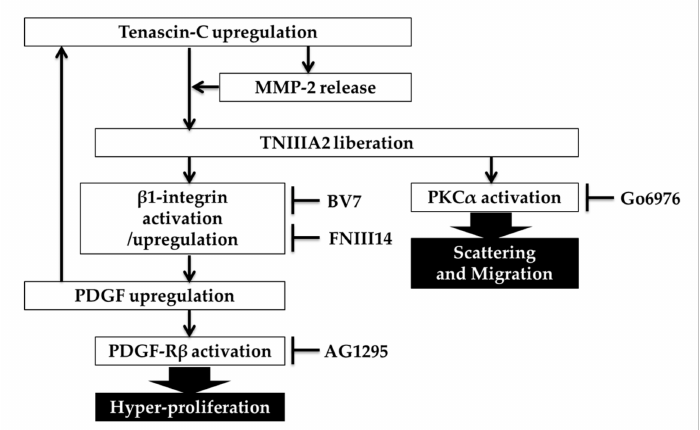
Figure 6. A proposed molecular process of the tenascin-C / TNIIIA2 / PDGF positive spiral loop in GBM cell proliferation and the TNIIIA2-induced GBM cell migration and scattering. Tenascin-C produced by GBM cells is cleaved by MMP-2 released by tenascin-C-stimulated GBM cells or fibroblasts. TNIIIA2 liberated from tenascin-C activates β 1-integrin and induces upregulation of PDGF, which in turn stimulates the expression of tenascin-C, suggesting a positive feedback loop for hyper-stimulation in GBM cells. TNIIIA2 also induces GBM cell scattering and migration via the PKC α